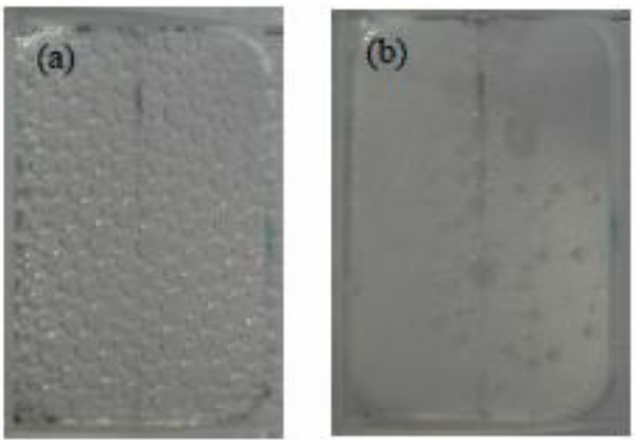
Figure 7. Foam produced by sodium dodecyl sulphate (SDS) solutions diluted by hard water at 20 CMC using ( a ) capillaries and ( b ) dishwasher